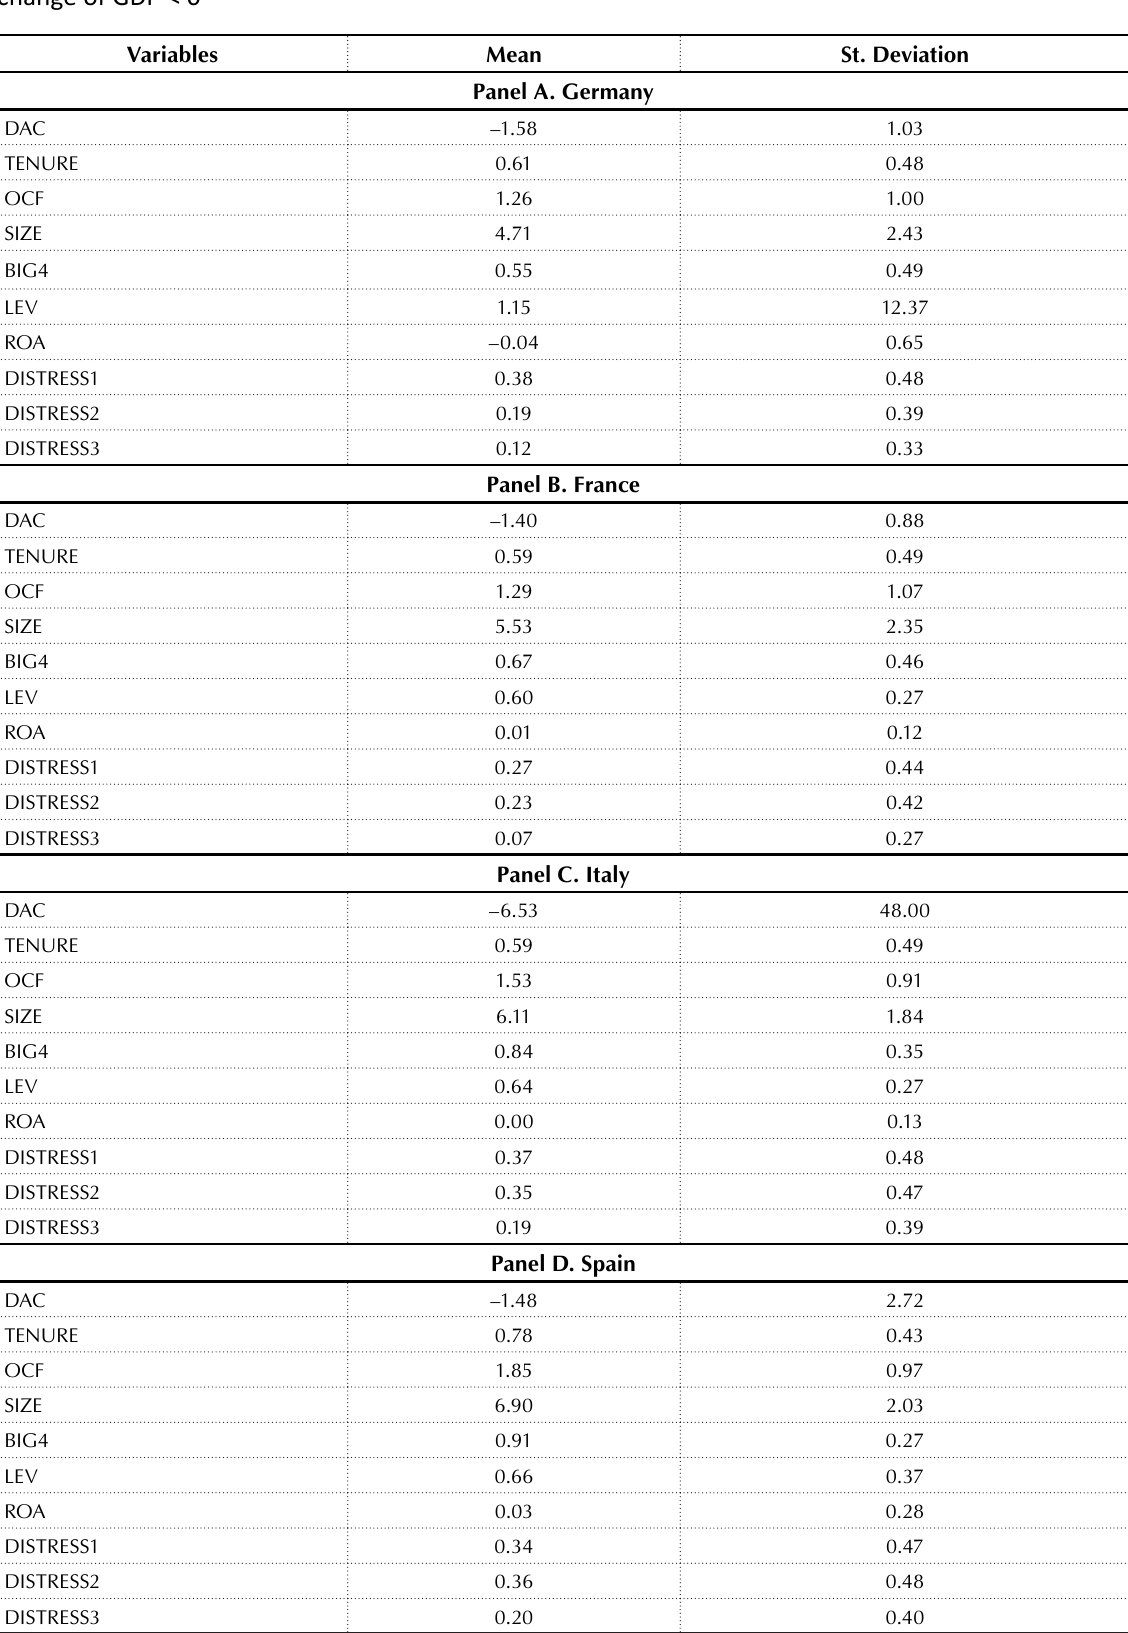
Table 2. Descriptive Statistics for Germany, France, Italy and Spain during the financial crisis for change of GDP <